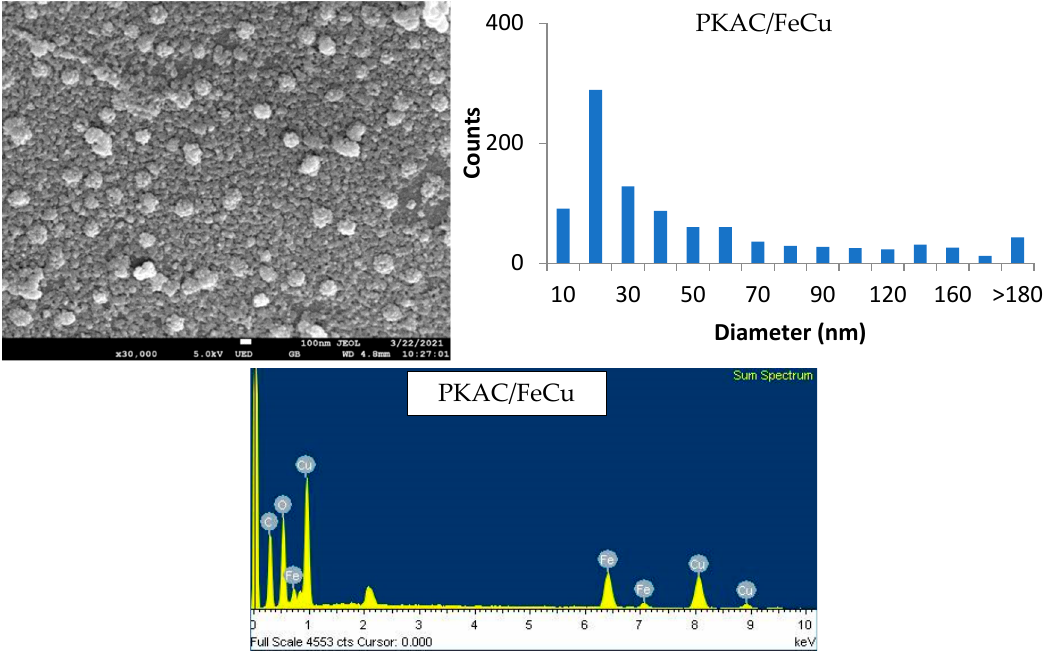
Figure 4. FESEM image, particle size distribution, and EDX spectrum for the bimetallic catalyst.